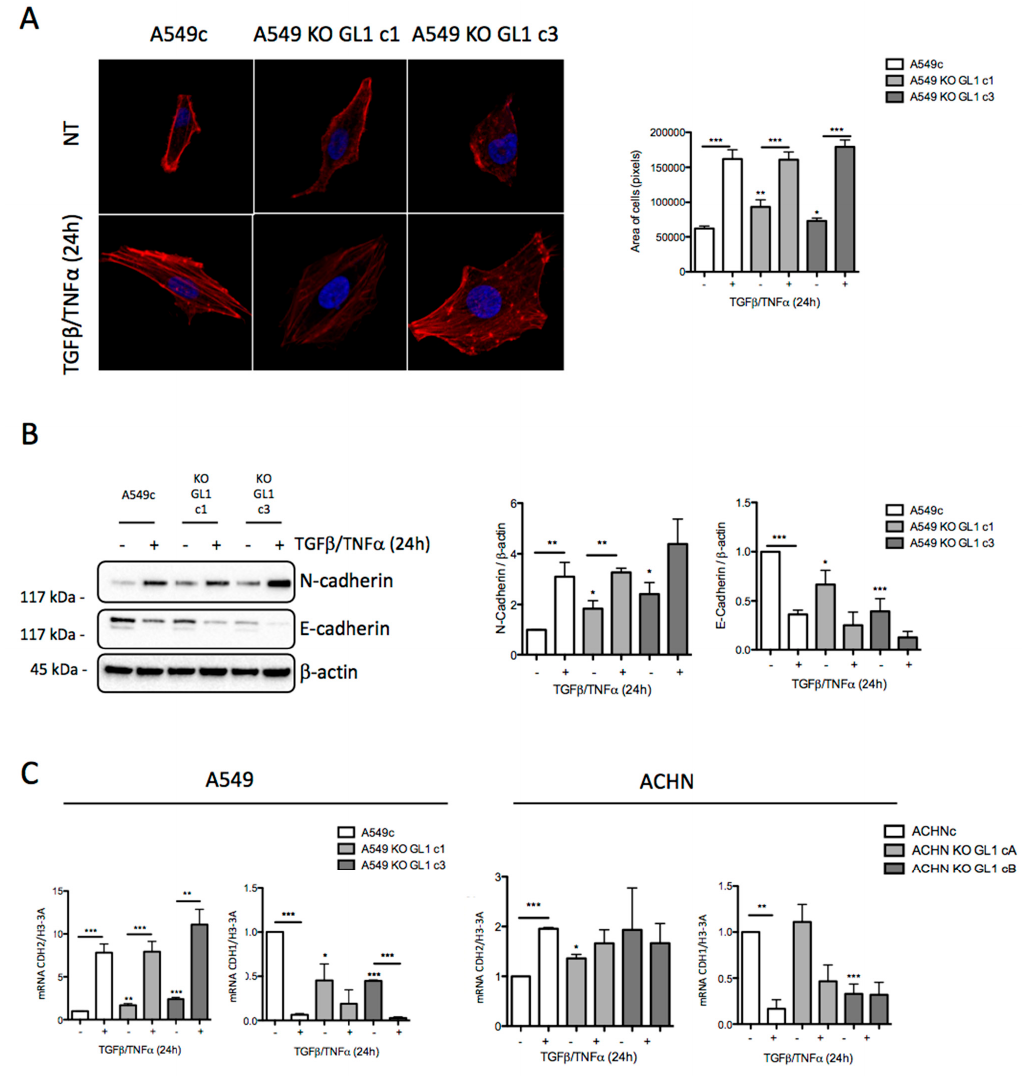
Figure 4. GABARAPL1 knockout leads to an induction of EMT. ( A ) Measurement of the area of A549c and A549 KO GABARAPL1 cells treated, or not, with TGF- β (5 ng/mL) and TNF- α (20 ng/mL) for 24 h. The cells were stained using rhodamine phalloidin, and the cell areas were measured using a confocal microscope and Image J software. Scale bar: 5 µm. Twenty cells were analyzed per condition, and in three independent experiments. ( B ) Western blotting analysis of N-cadherin and E-cadherin levels in A549c and KO GABARAPL1 cells untreated or treated with TGF- β (5 ng/mL) and TNF- α (20 ng/mL) for 24 h. β -actin was used as loading control. Protein levels were quantified using Image Lab. ( C ) mRNA levels of CDH1 and CDH2 were measured by qRT-PCR in A549c and A549 KO GABARAPL1 cells, and in ACHNc and ACHN KO GABARAPL1 cells, untreated or treated with TGF- β 5 ng/mL and TNF- α 20 ng/mL for 24 h. The values calculated by the ∆∆ CT method are relative to H3-3A levels, and are expressed as fold change.